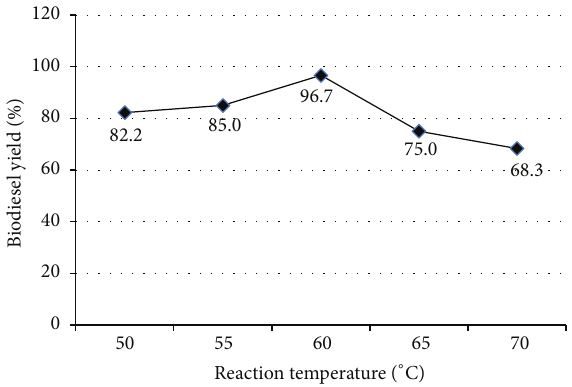
Figure 7: Reaction temperature ( ∘ C) versus biodiesel yield (%).